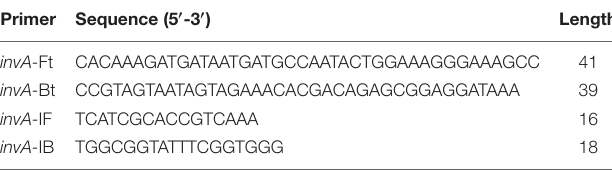
TABLE 2 | Primer sequences of the target genes.